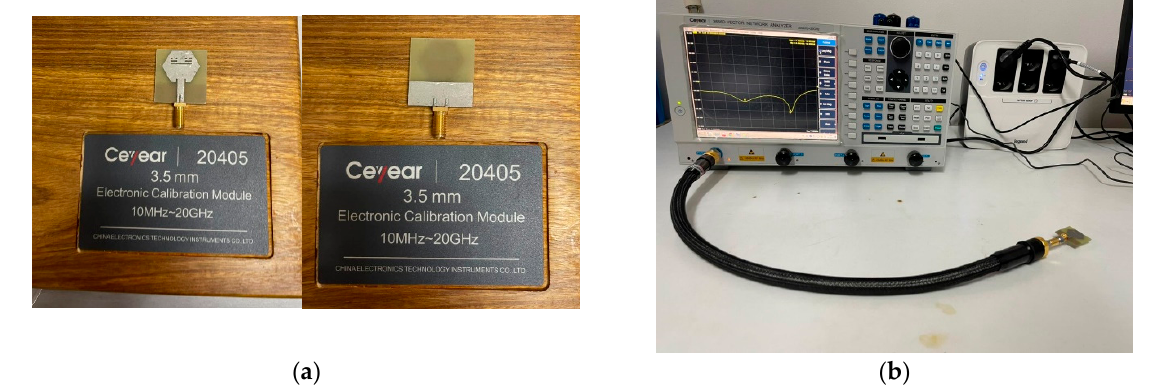
Figure 12. ( a ) Studied antenna prototype; ( b ) the experimental setup.